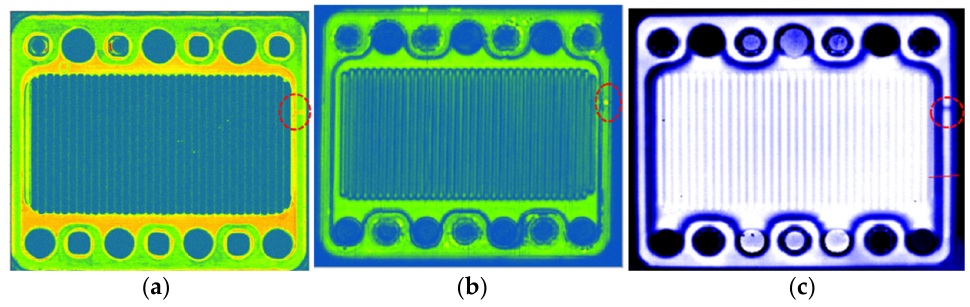
Figure 10. Comparison of the images of the same cell element with a defect of missing glass solder: ( a ) obtained by the ultrasound in immersion technique; ( b ) obtained by air-coupled ultrasound; ( c ) obtained by flash excited